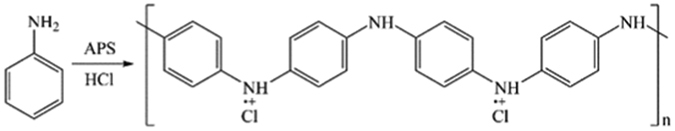
Reaction for the chemical oxidative polymerization of aniline with APS acting as the oxidant in HCl solution.